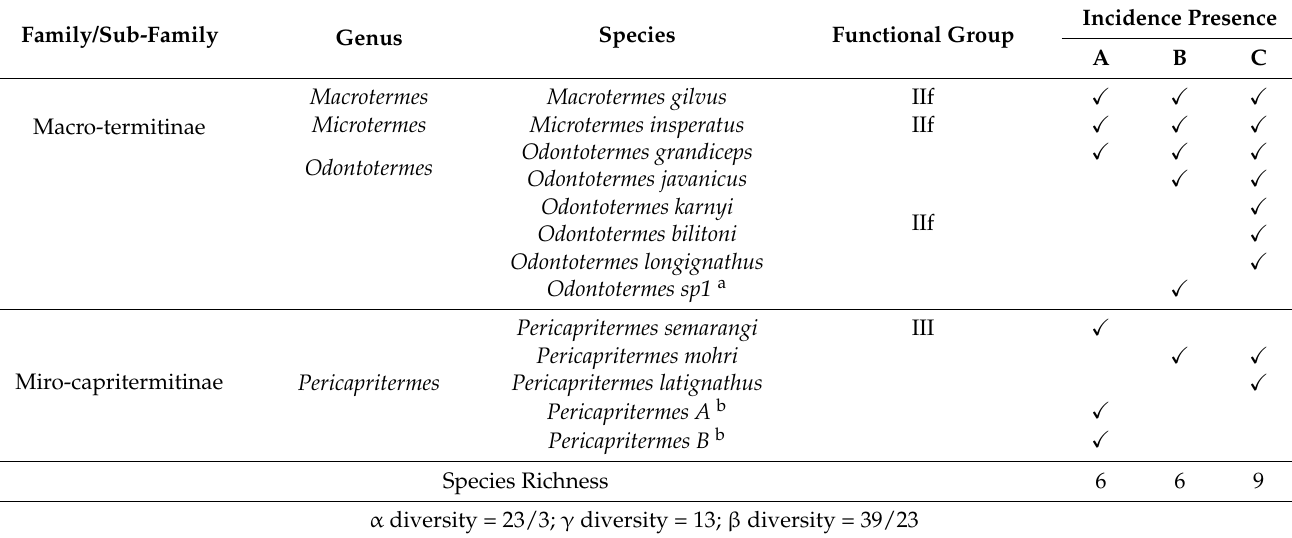
Table 3. Species identity and richness from three platinum teakwood plantations. (A = 5 years, B = 6 years, C = 9 years after establishment).